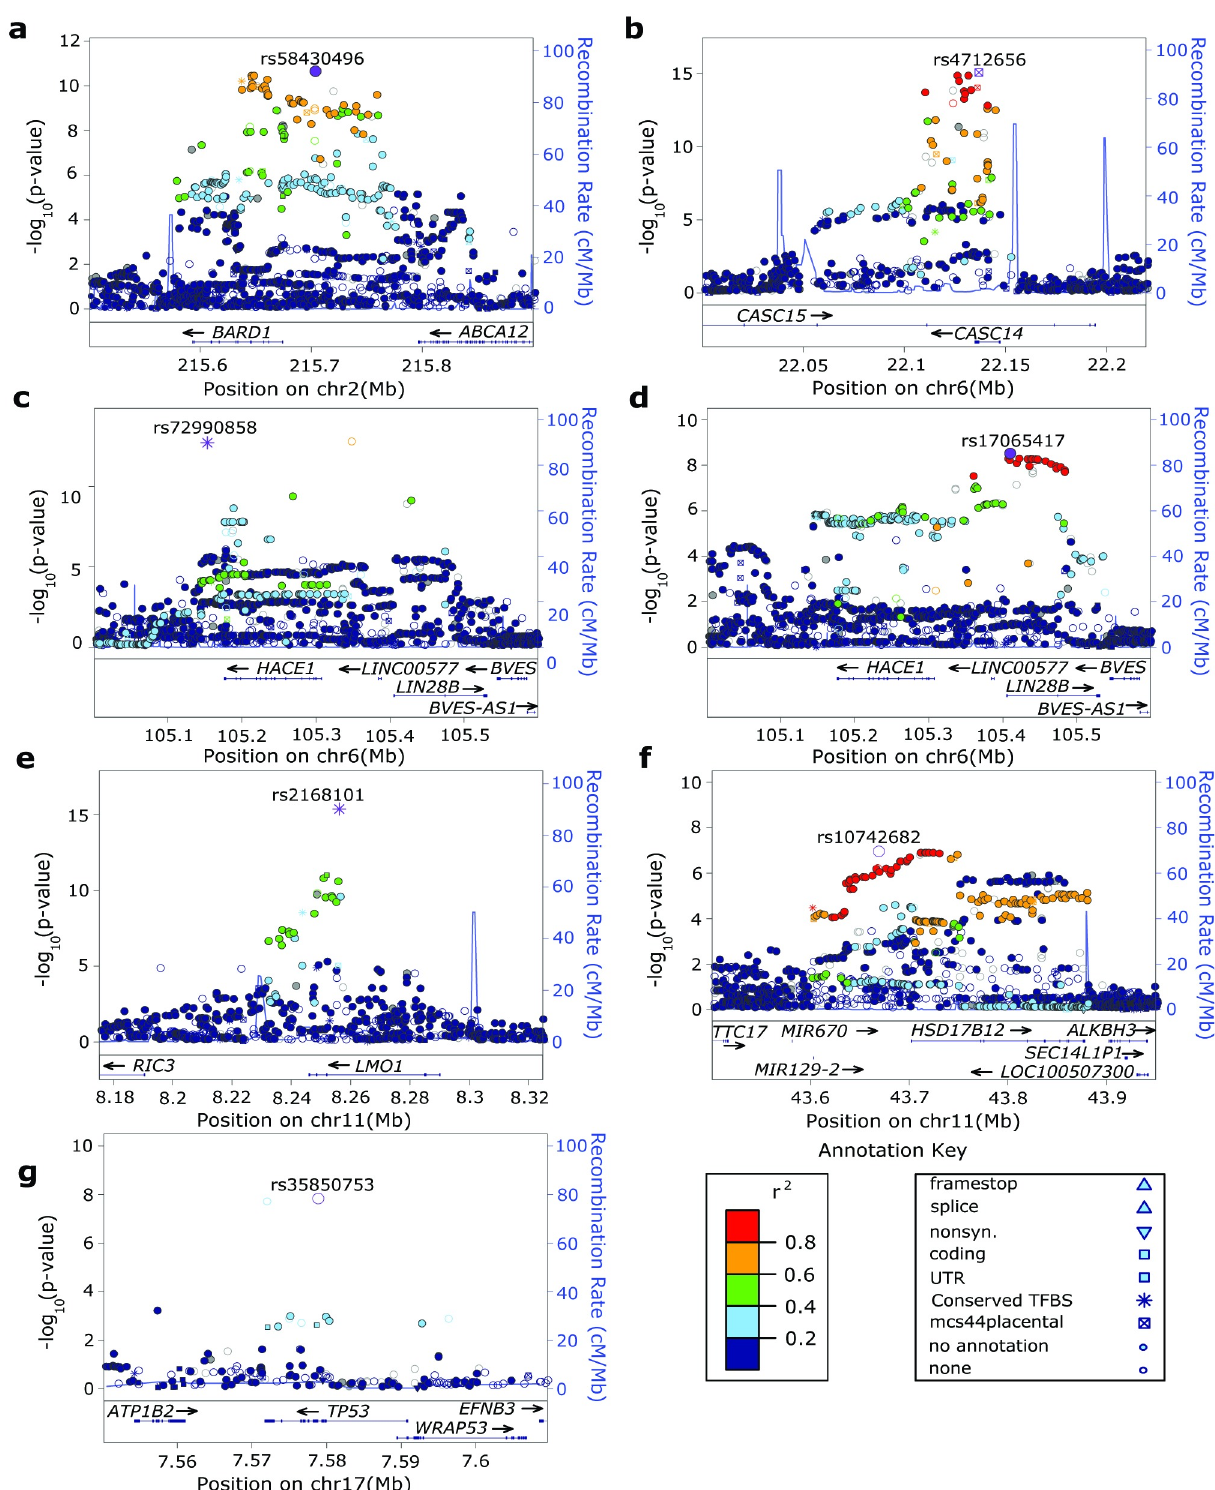
Fig 2. Genome-wide imputation confirms previously reported neuroblastoma susceptibility loci and identifies additional variants of greater statistical significance. Regionalassociationplots of genotyped and imputedSNPs at previouslyreportedneuroblastoma susceptibilityloci identifiedby GWAS. Plots generatedusing LocusZoom. Y-axes represent the significance of association(-log10